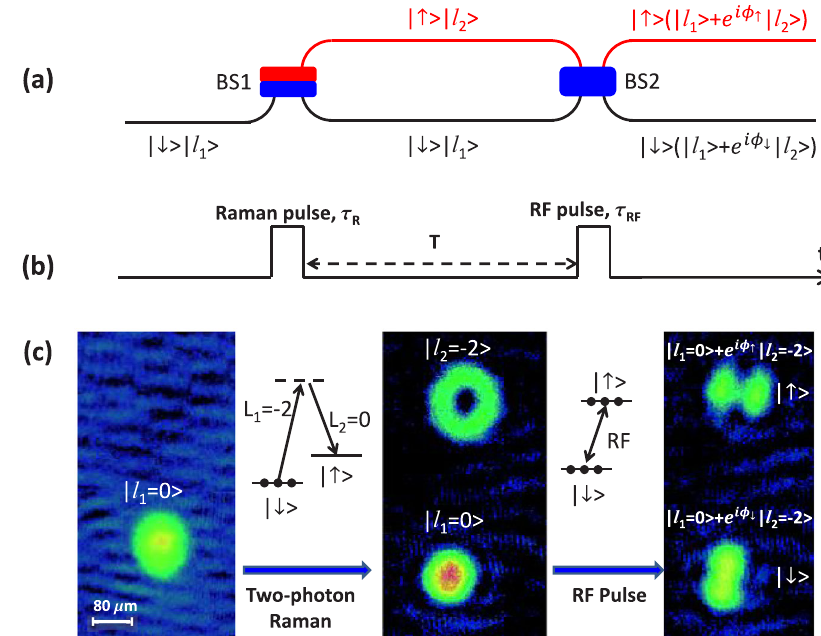
Fig. 1 Schematics of the vortex matter-wave interferometer. a The interferometer is composed of two BSs (BS1 and BS2). The input vortex state l 1 j i is in the spin state #j i . The BS1 (a two-photon Raman pulse) splits the input state #j i l 1 j i into two paths #j i l 1 j i and "j i l 2 j i . The BS2 (an RF pulse) combines two vortex states l 1 j i and l 2 j i in each spin state. ϕ ↑ and ϕ ↓ are the relative phases between the two vortex modes in the two spin states, respectively. b is the pulse sequence. τ R and τ RF are the periods of the Raman and RF pulses, respectively. T is the evolution time. c An exemplary interferometer between two vortex states l 1 ¼ 0 j i and l 2 ¼ (cid:2) 2 j i . The Raman pulse contains two optical fi elds with OAM numbers L 1 = − 2 and L 2 = 0. After BS1, there is a vortex state l 1 ¼ 0 j i ( l 2 ¼ (cid:2) 2 j i interfere in each spin